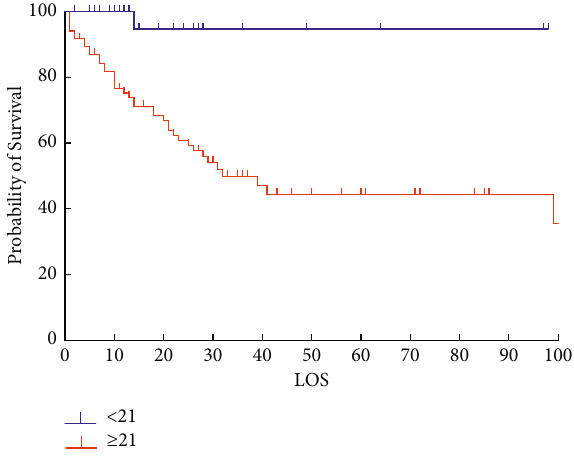
Figure 5: Survival curve of day 3 by score of 21.